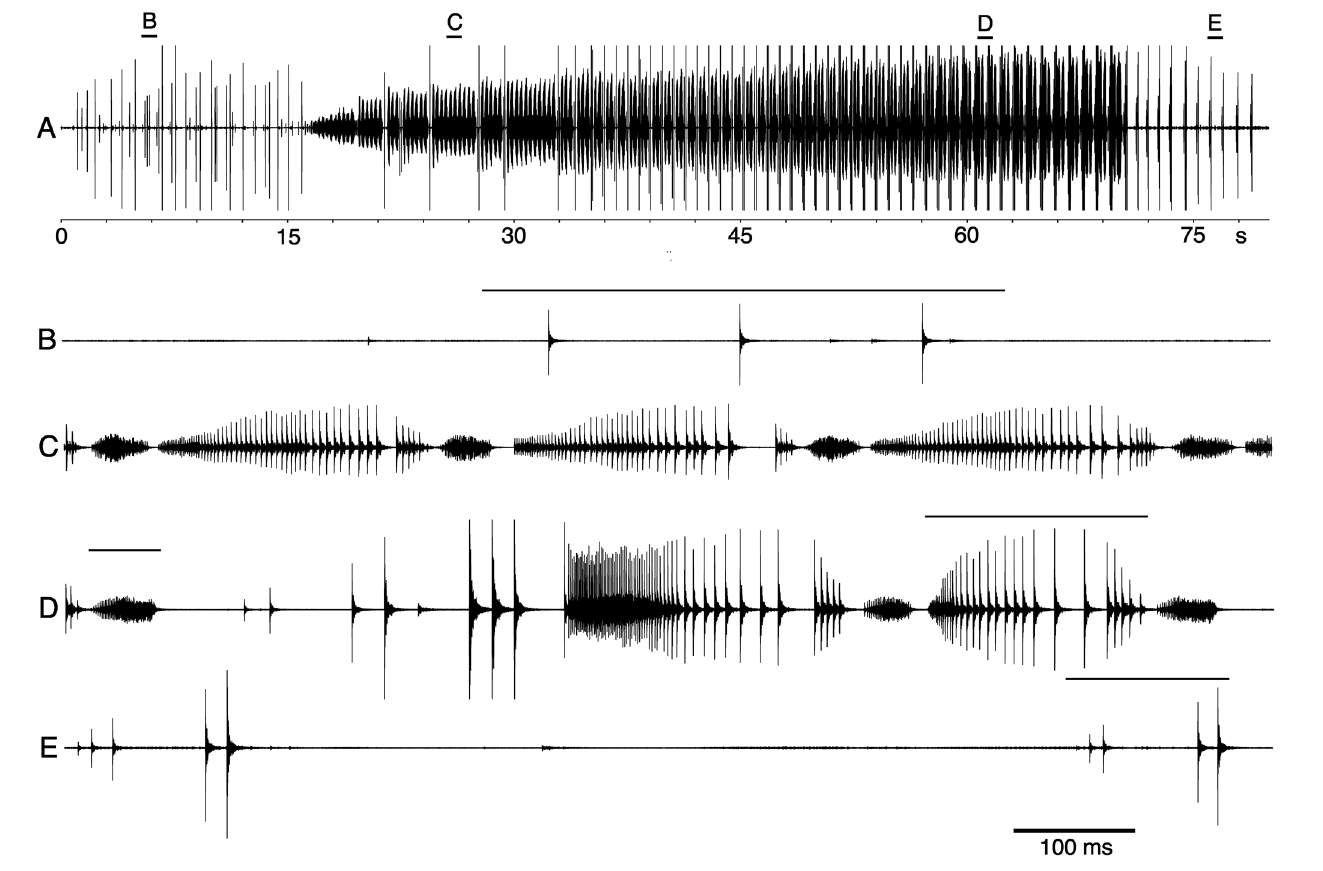
Figure 11. Oscillograms of male calling song of E. diuturna sp. n. A. Overview with indication of the origin of the details ( B–E ). In B, D and E. the origin of the spectra shown in Fig. 12 is